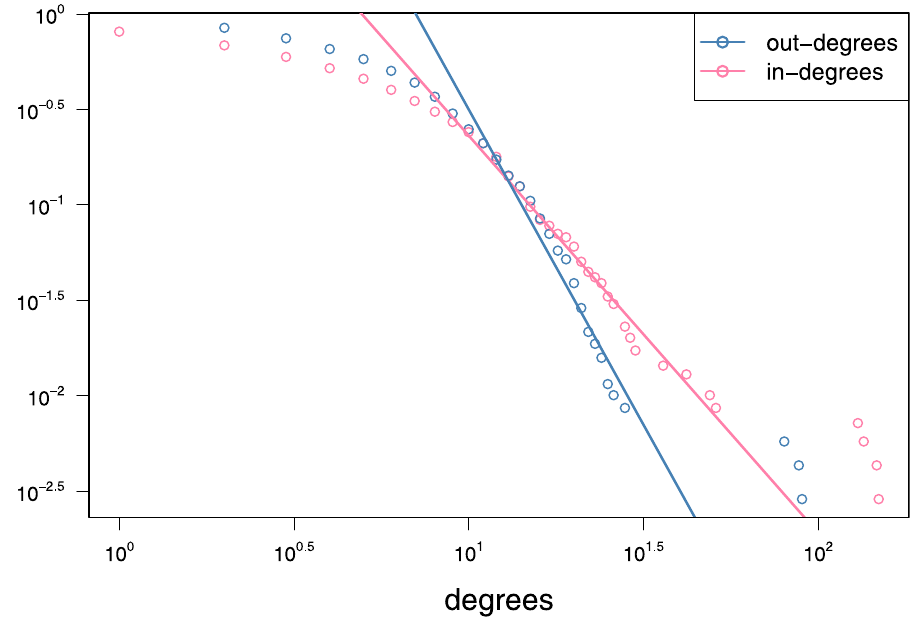
Fig 6. Complementary CDF of node degrees for the Pokec sample network. The solid lines are fitted by scatters excluding non-linear parts at the heads and outliers at the tails.